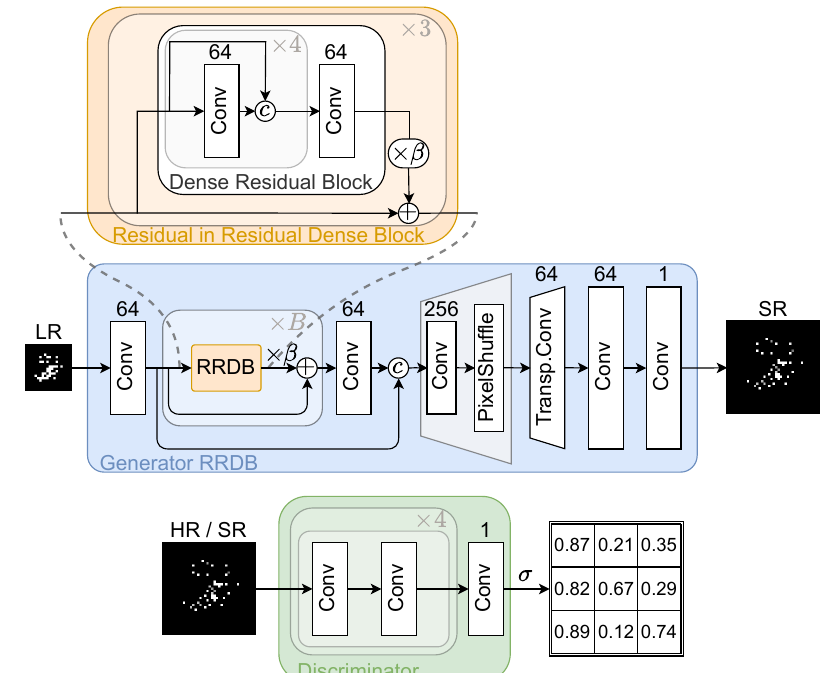
Figure 2: Architecture of modified generator network from ESRGAN (upper) and discriminator network modified from the SRGAN